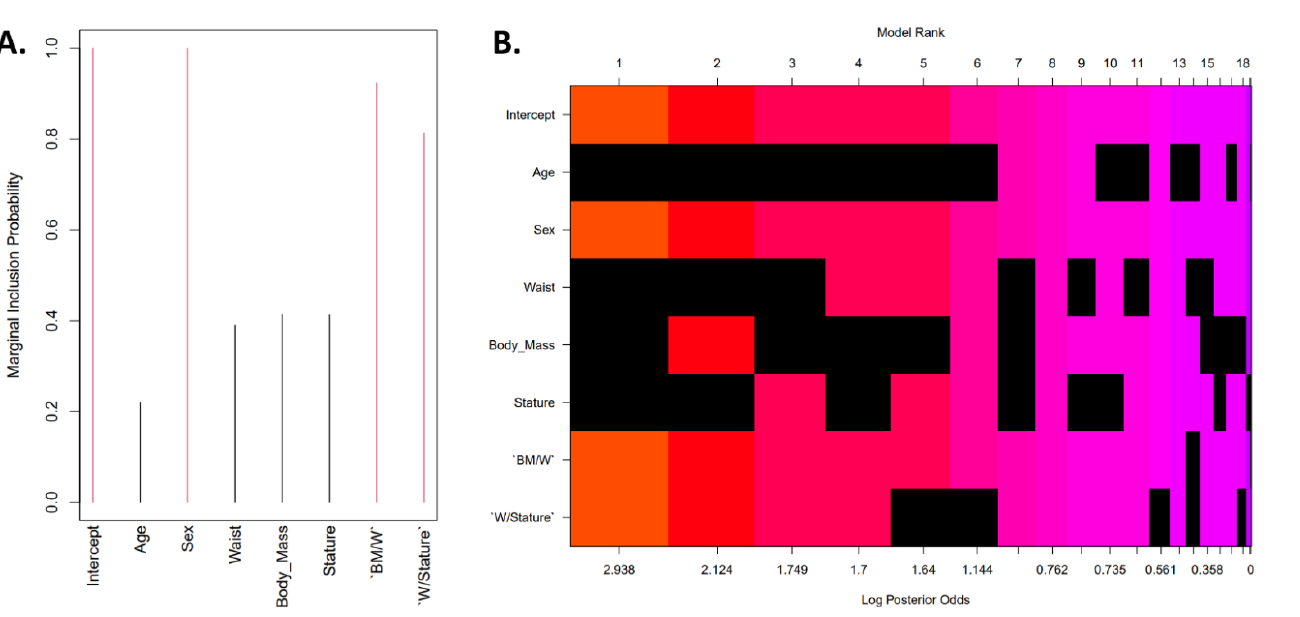
Figure 2. Visualization of the model space with all of the potential predictors. ( A ) Marginal posterior inclusion probabilities for each of the covariates. The marginal posterior inclusion probabilities greater than 0.5 are shown in red. ( B ) Zellner–Siow prior distributions on the regression coefficients. The rows correspond to each of the variables and intercept (labels on the y-axis) while the x-axis corresponds to the possible models. The models are sorted by their posterior probability from best (left) to worst (right) with the rank on the top x-axis (each column represents one model). Excluded variables in a model are shown in black for each column and the variables included are colored (the color is related to the log posterior probability with orange as the highest probability model). BM: body mass; BM/W: body mass-to-waist ratio; W: waist girth; W/Stature: waist-to-stature ratio.